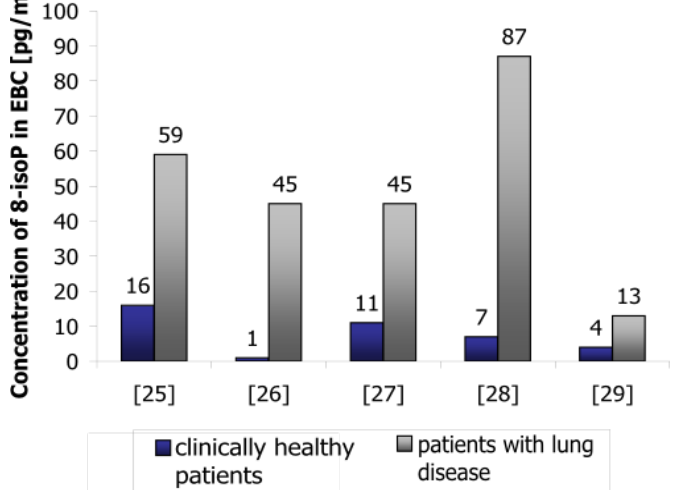
in EBC in healthy and non-healthy subjects [25–29]. 2α